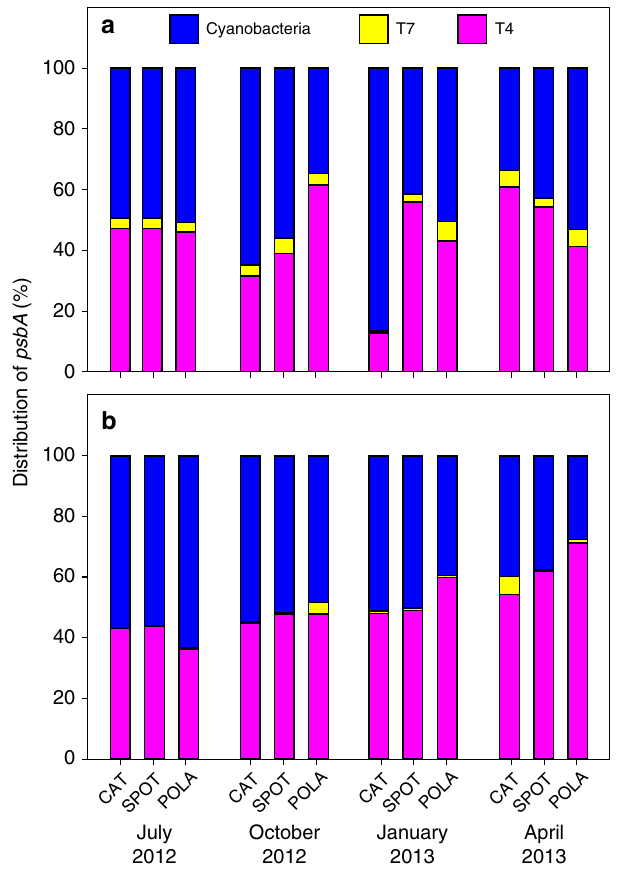
Fig. 4 Phage and cyanobacteria expression of the PS-II reaction center. Relative abundance of psbA of cyanobacteria (Synechococcus and Prochlorococcus) , T4-like cyanophages, and T7-like cyanophages out of total psbA in a metagenomes and b metatranscriptomes. Each stacked bar chart represents a single